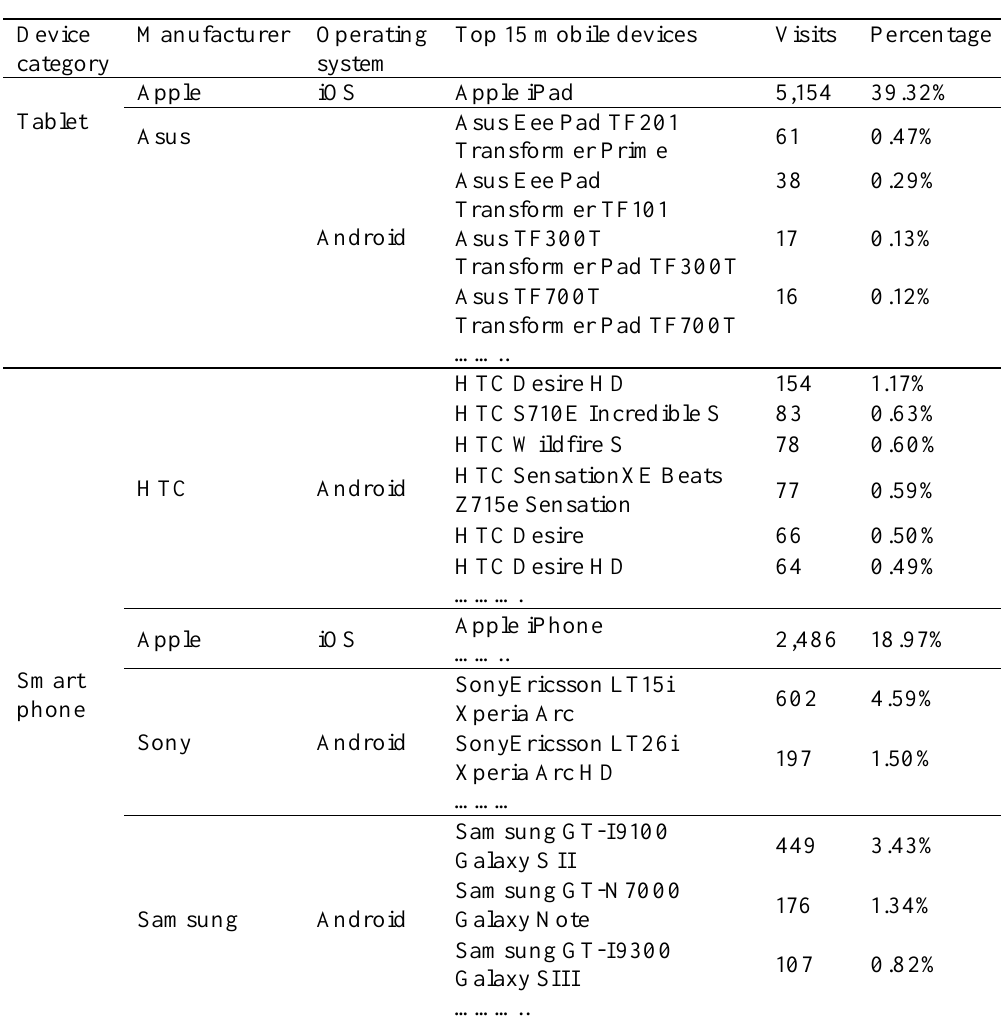
Detailed Info of Mobile